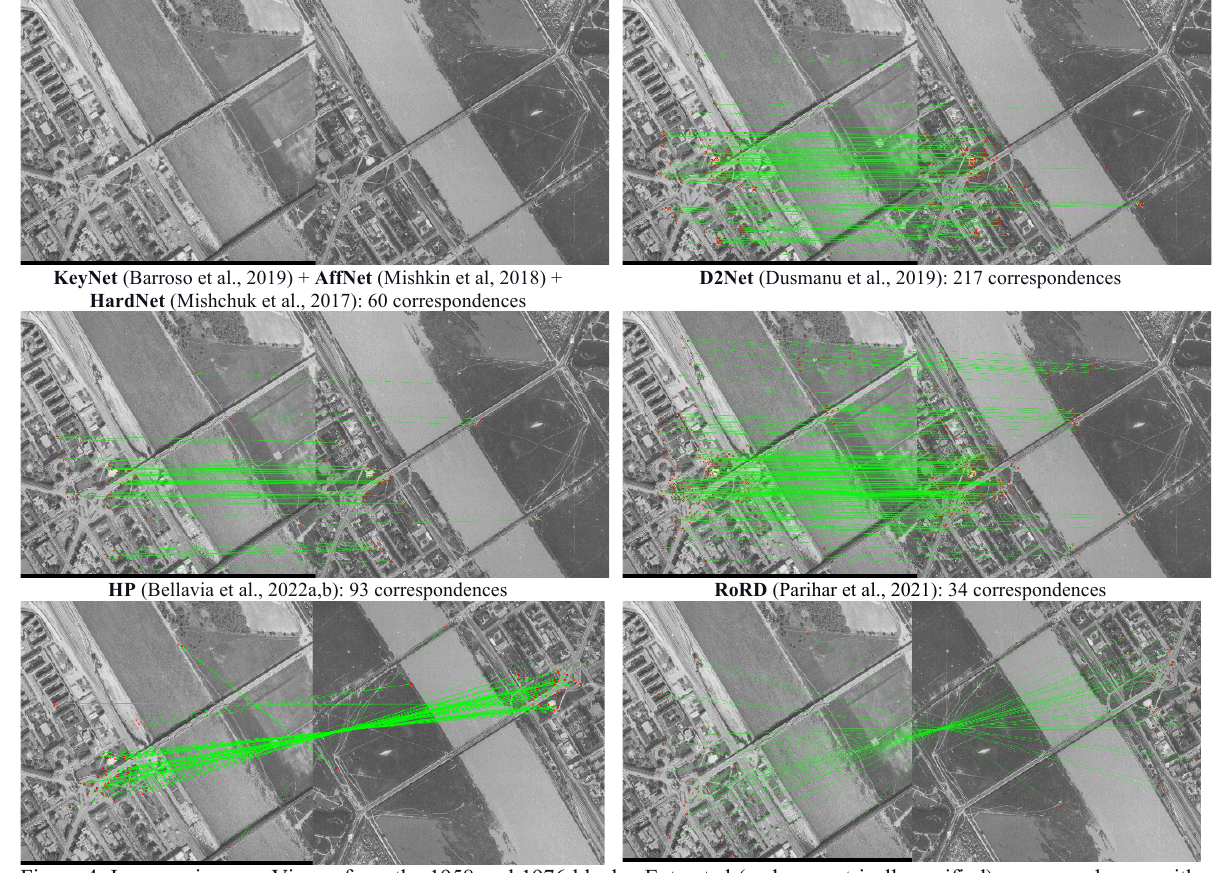
Figure 4. Image pairs over Vienna from the 1958 and 1976 blocks. Extracted (and geometrically verified) correspondences with hand-crafted, hybrid and deep learning approaches. Only HP and RoRD methods could handle rotated images.